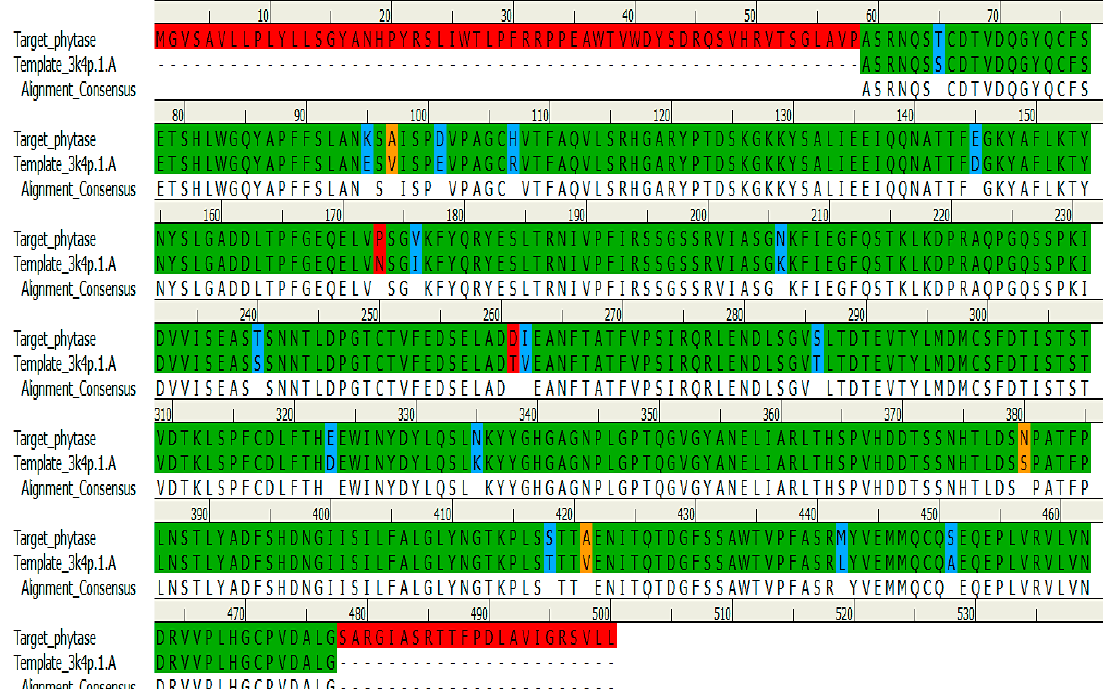
Figure 2. The alignment of Fusarium oxysporum phytase domain and Aspergillus Niger Phytase template (PDB code: 3K4P) that yielded the homology model of Fophy. The identical residues are represented by green color, residues with strong similarity are represented by blue, and residues with weak identity are in orange, whereas the red color represents the non-matching residues.